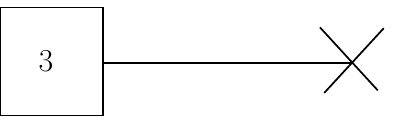
Figure 1 . We will denote the theory T x by such a graph and use it as a building block gauging either SU(3) or SU(3) = Z 3 symmetry with some Chern-Simons